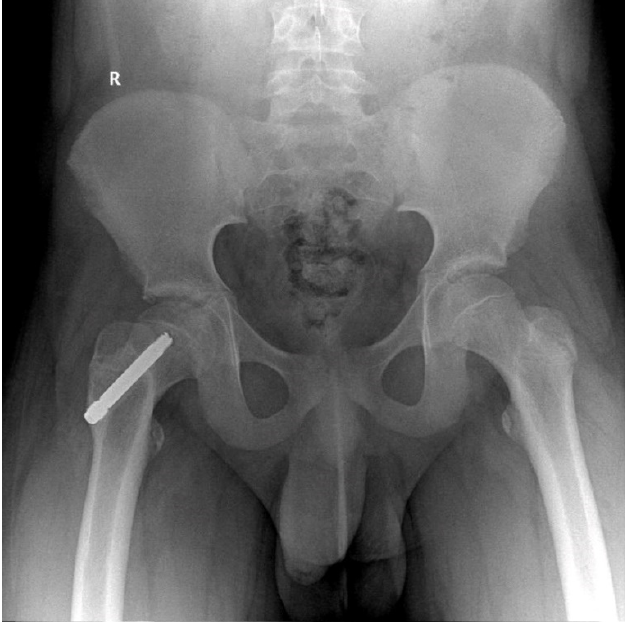
Figure 2. Male patient, 9 years old, slipped screw at 16 months follow-up.